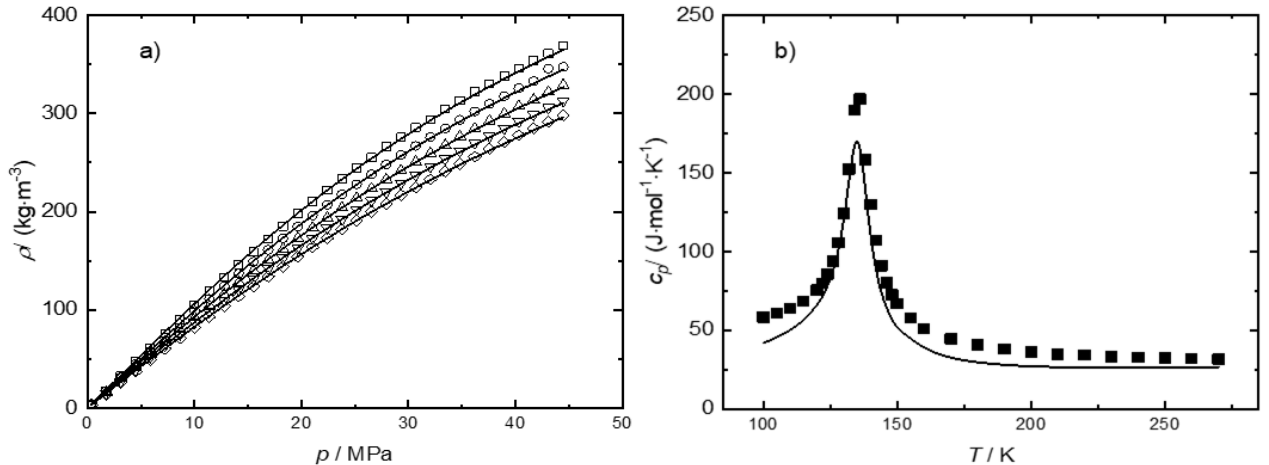
Figure 9. ( a ) Single-phase densities and ( b ) isobaric heat capacities for pure nitrogen. In ( a ), the symbols represent the experimental data [80] at temperatures of 313.15 K (squares), 333.15 K (circles), 353.15 K (triangles), 373.15 K (inverted triangles) and 393.15 (diamonds). In ( b ), the symbols represent the experimental data at 5.07 MPa [81]. The continuous lines are the predictions with the SAFT- γ Mie approach in ( a , b ). Table 12. Absolute average relative deviations (Δ AARD ) between experimental and calculated values obtained either with the SAFT- γ Mie approach or the Helmholtz energy equation of state (Helm- holtz-EoS). p vap , ρ sat, ρ and c p are vapour pressure, saturated-liquid density, single-phase density and isobaric-specific heat capacity, respectively. N denotes the number of points.